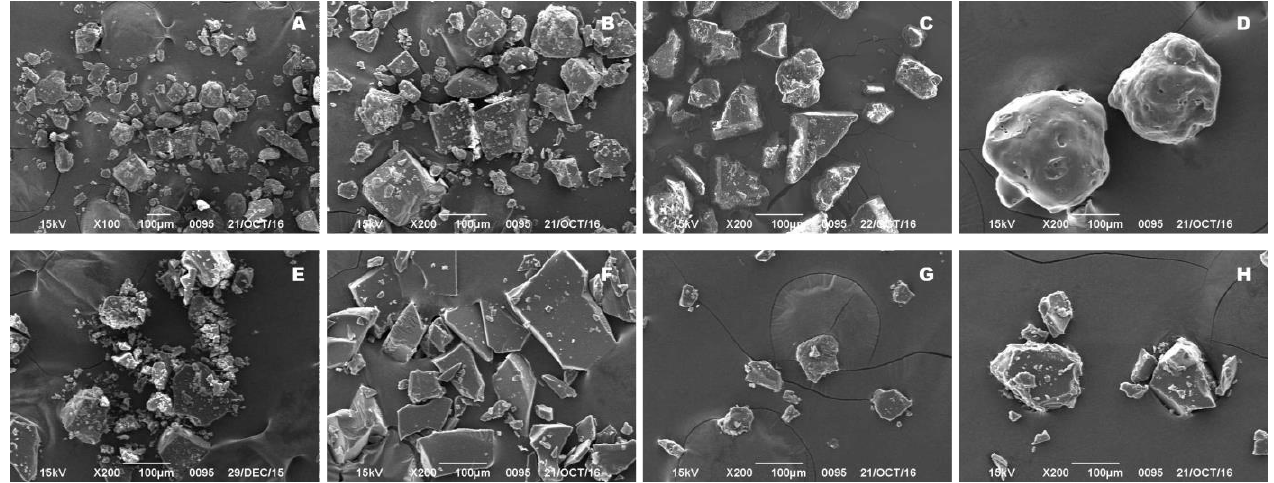
Figure 2. SEM micrographs showing crystalline FEL (( A ), 100×), crystalline FEL (( B ), 200×), FEL PM (( C ), 200×), Soluplus ® (( D ), 200×), FEL PA (( E ), 200×), faSDDS SE (( F ), 200×), faSDDS QC (( G ), 200×), and faSDDS HME (( H ), 200×).